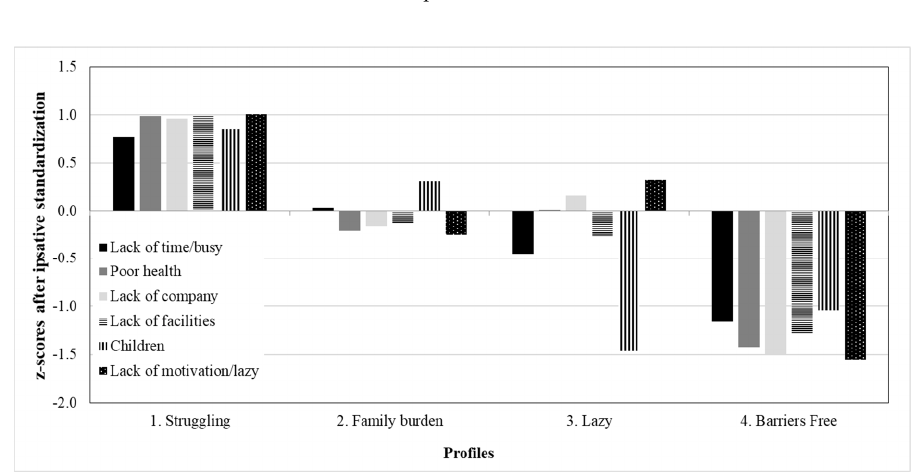
Figure 2. Characteristics of the latent profiles on the physical activity barriers perceived by parents.